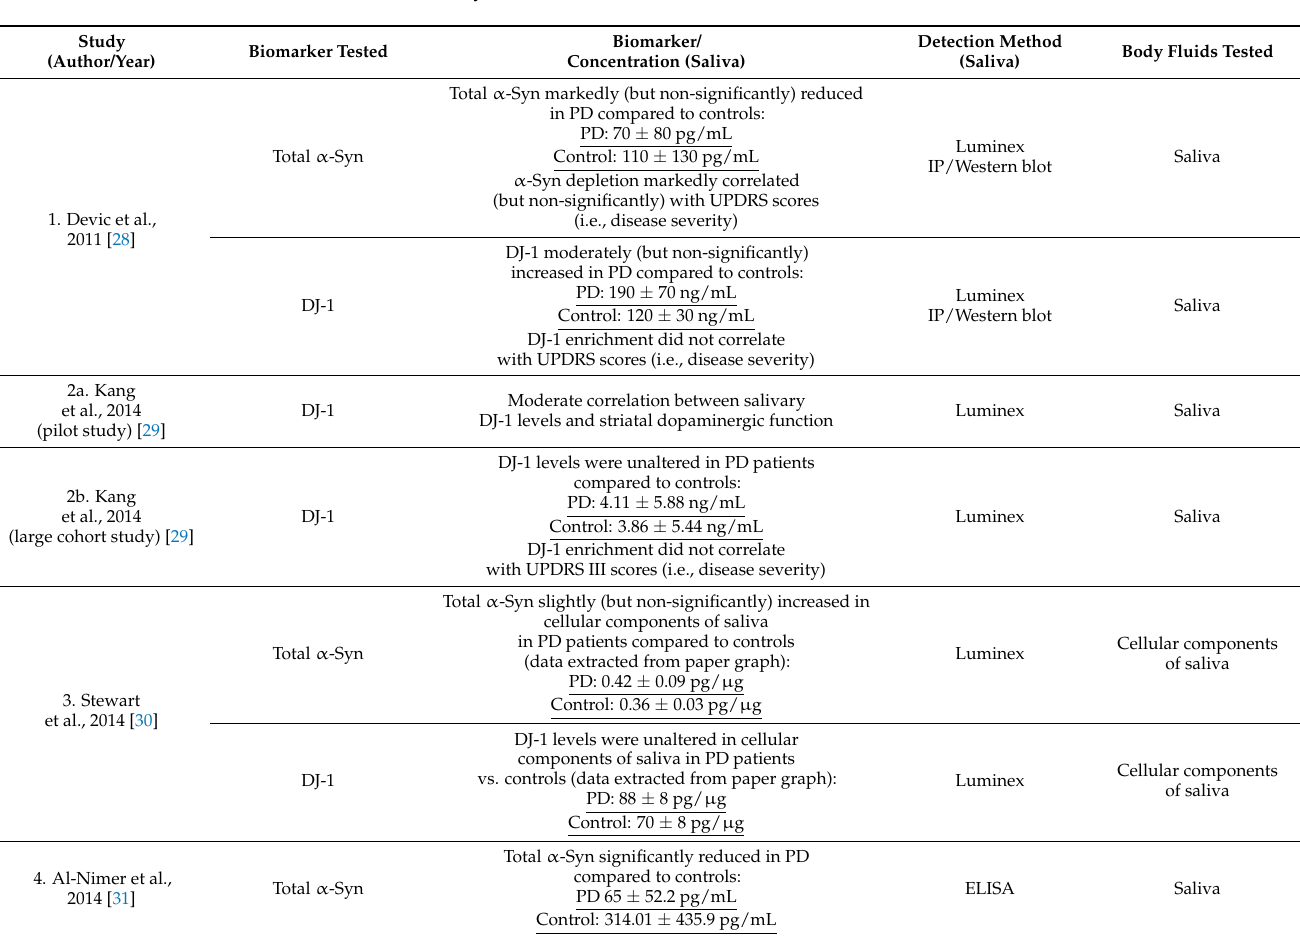
Table 4. Salivary biomarkers for